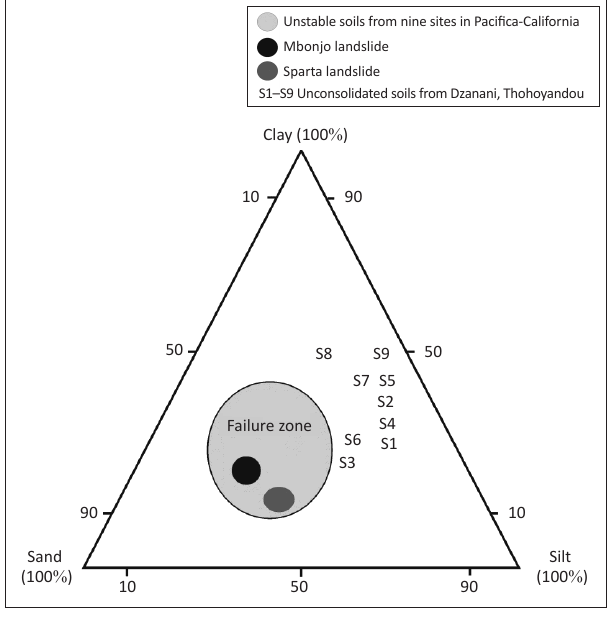
FIGURE 6: Location of Dzanani unconsolidated soil samples on landslide susceptibility ternary